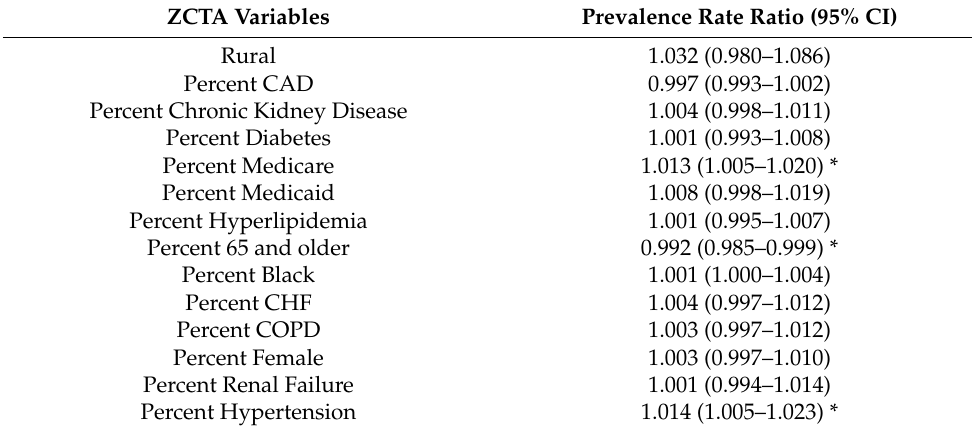
Table 2. ZCTA Level prevalence rate ratios for covariates.